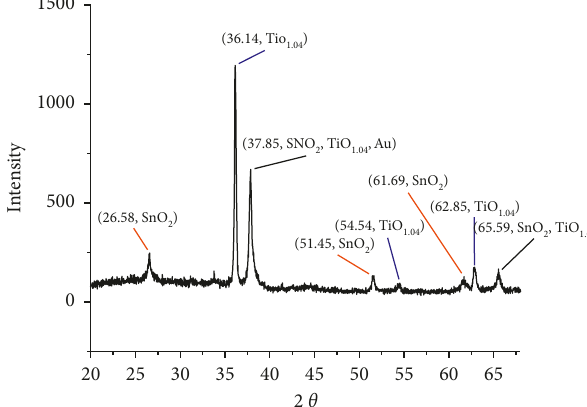
Figure 4: X-ray diffraction spectrum of TiO annealing synthesized on FTO